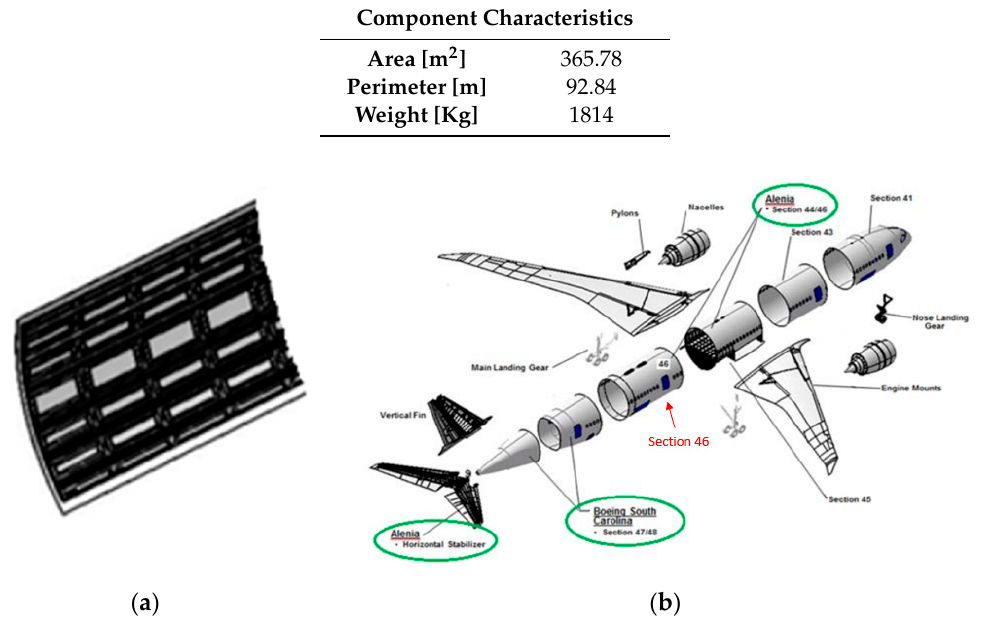
Figure 1. A fuselage panel ( a ) Section 46 of Boeing 787 Dreamliner ( b ) case study of the work [48].